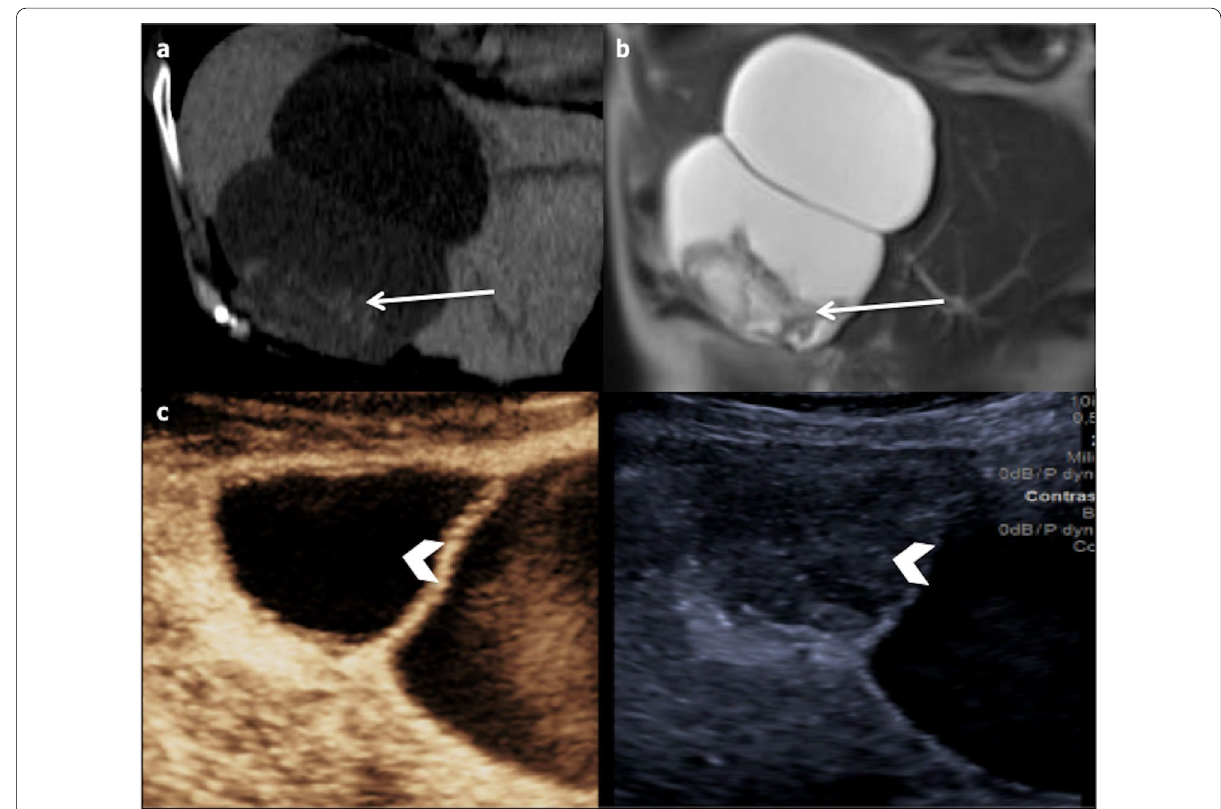
Fig. 6 Bilobulated haemorrhagic hepatic cyst in a 73-year-old female. a Coronal non-enhanced computed tomography shows a bilobulated cyst with focal hyperattenuation in the inferior part (arrow); b coronal T2-weighted magnetic resonance imaging shows heterogeneous hypointensity inside the inferior part of the cyst (arrow). c Contrast-enhanced ultrasonography confirms the non-enhancement of the cystic part of the lesion